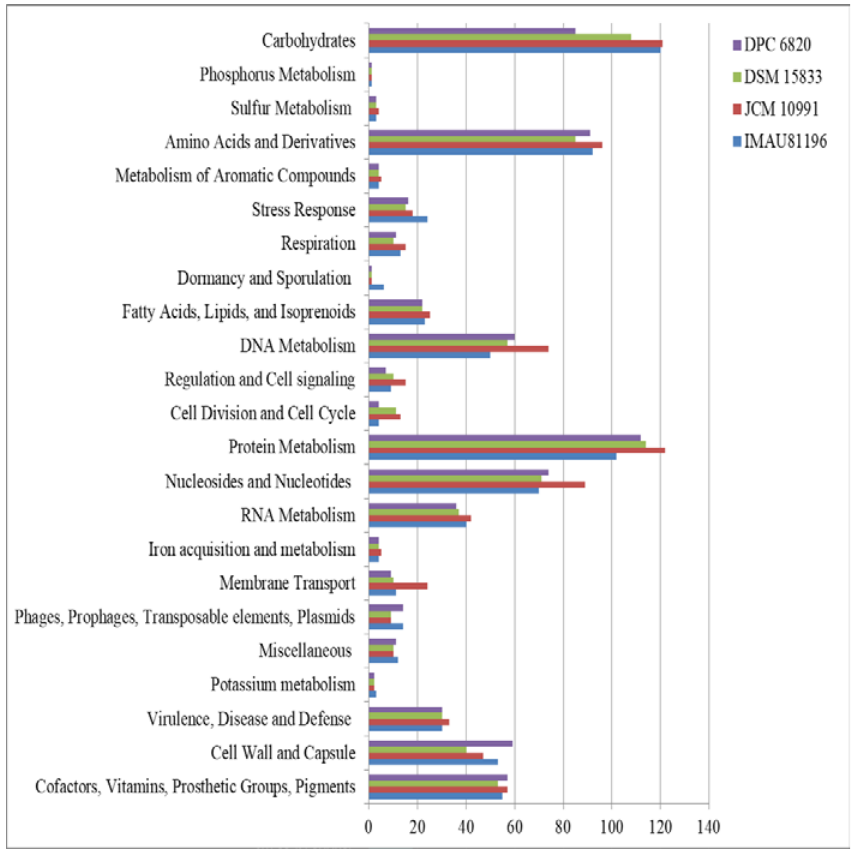
Figure 3. RAST annotation of four L. equi